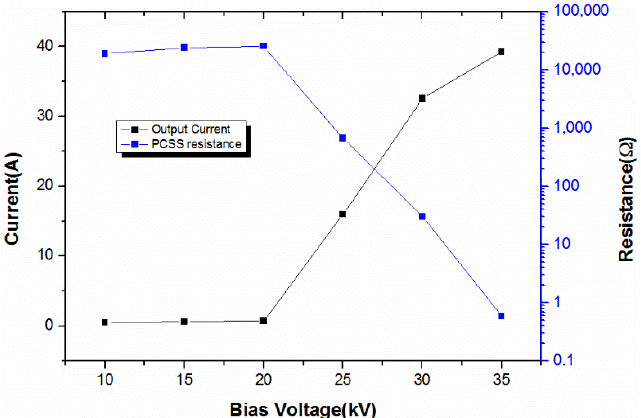
Figure 8. GaAs PCSS resistance versus the bias voltage.